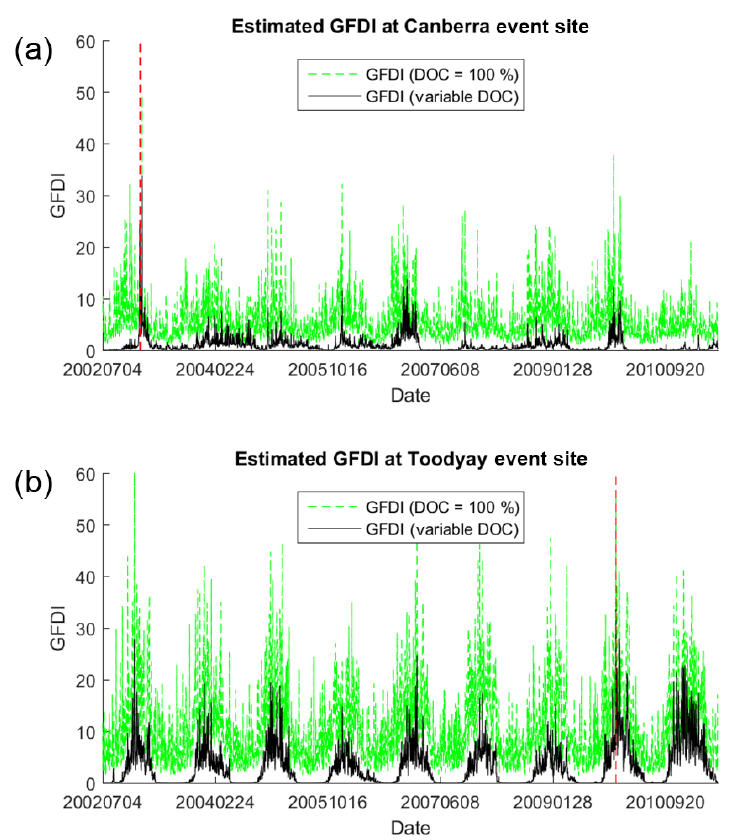
Figure 10. Grassland Fire Danger Index (GFDI) time series plot at Weston Creek, ACT, from July 2002 to June 2011 (a) and at Toodyay, WA, from July 2002 to June 2011 (b) , where the vertical dash line indicates the date of fire event on 18 January 2003 for the Canberra fire and on 29 December 2009 for the Toodyay fire. The solid black line is estimated GFDI time series computed from estimated degree of curing (DOC), whereas the green dashed line is GFDI time series computed from constant DOC at